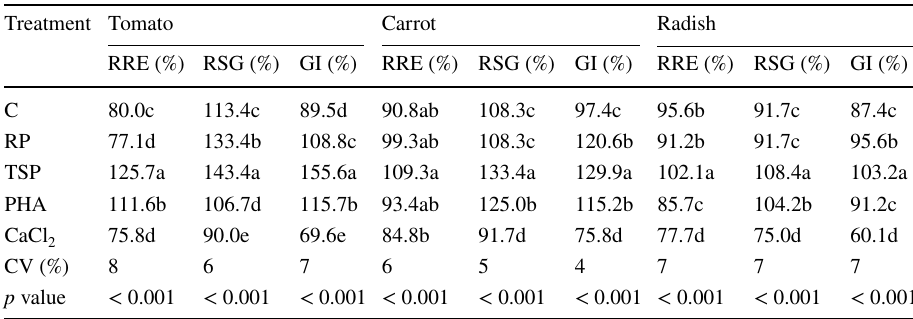
Table 4 Effect of treatments on the phytotoxicity of cow dung– waste paper